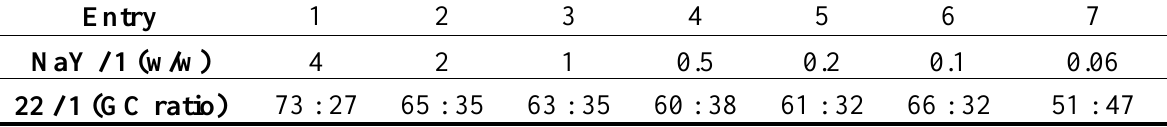
Table 3. Methanolysis of 4-cyanopyridine ( 1 ): dependence on catalyst-to-substrate ratio (reflux 15